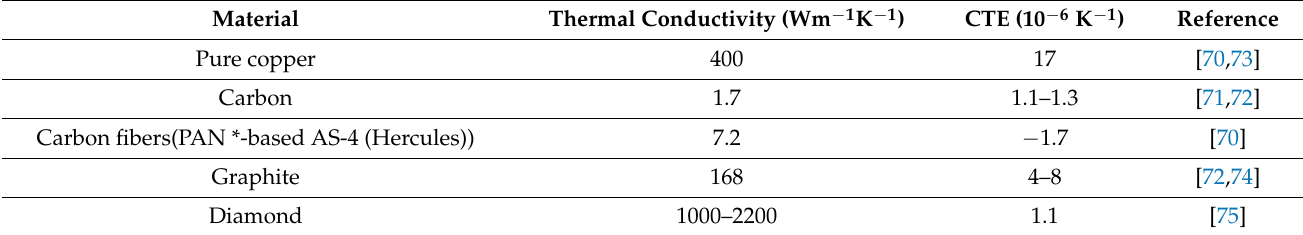
Table 5. Thermal properties of Cu and several allotropes of